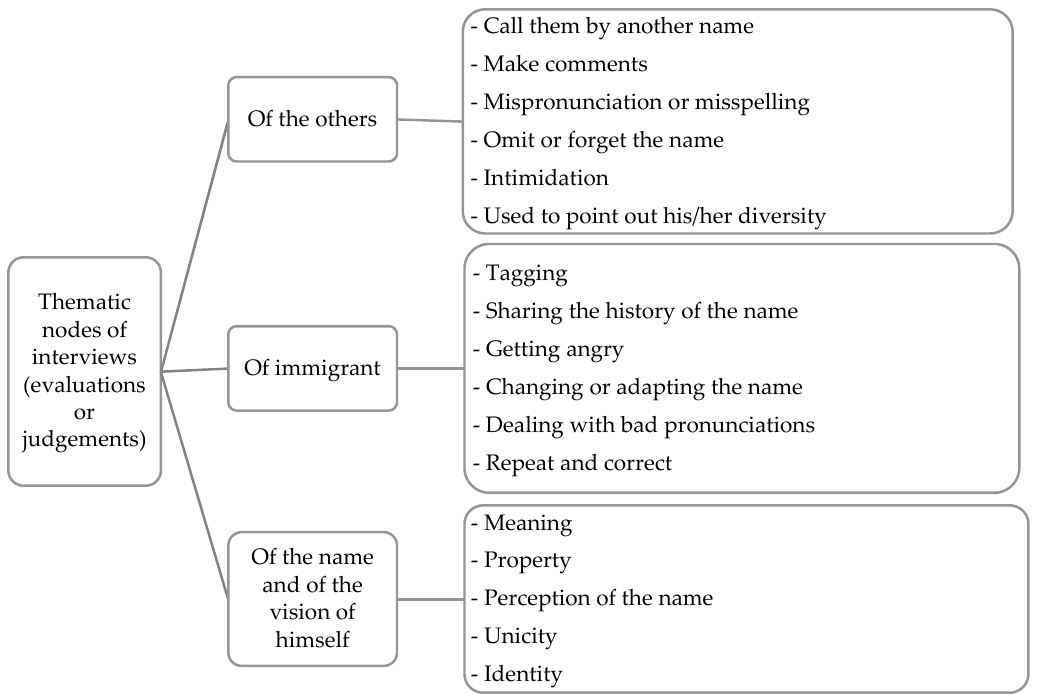
Figure 3. Thematic nodes associated with given names in immigrant interviews (based on Schlote (2018, p. 28)).